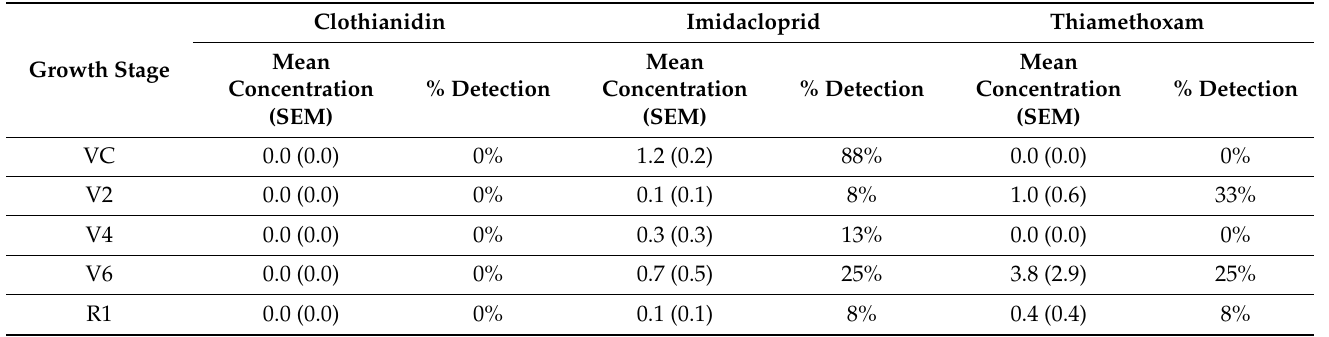
Table A4. Mean concentration (ng/g) and percent detection detected in soybean leaf tissue from untreated plots at each sampled growth stage across all